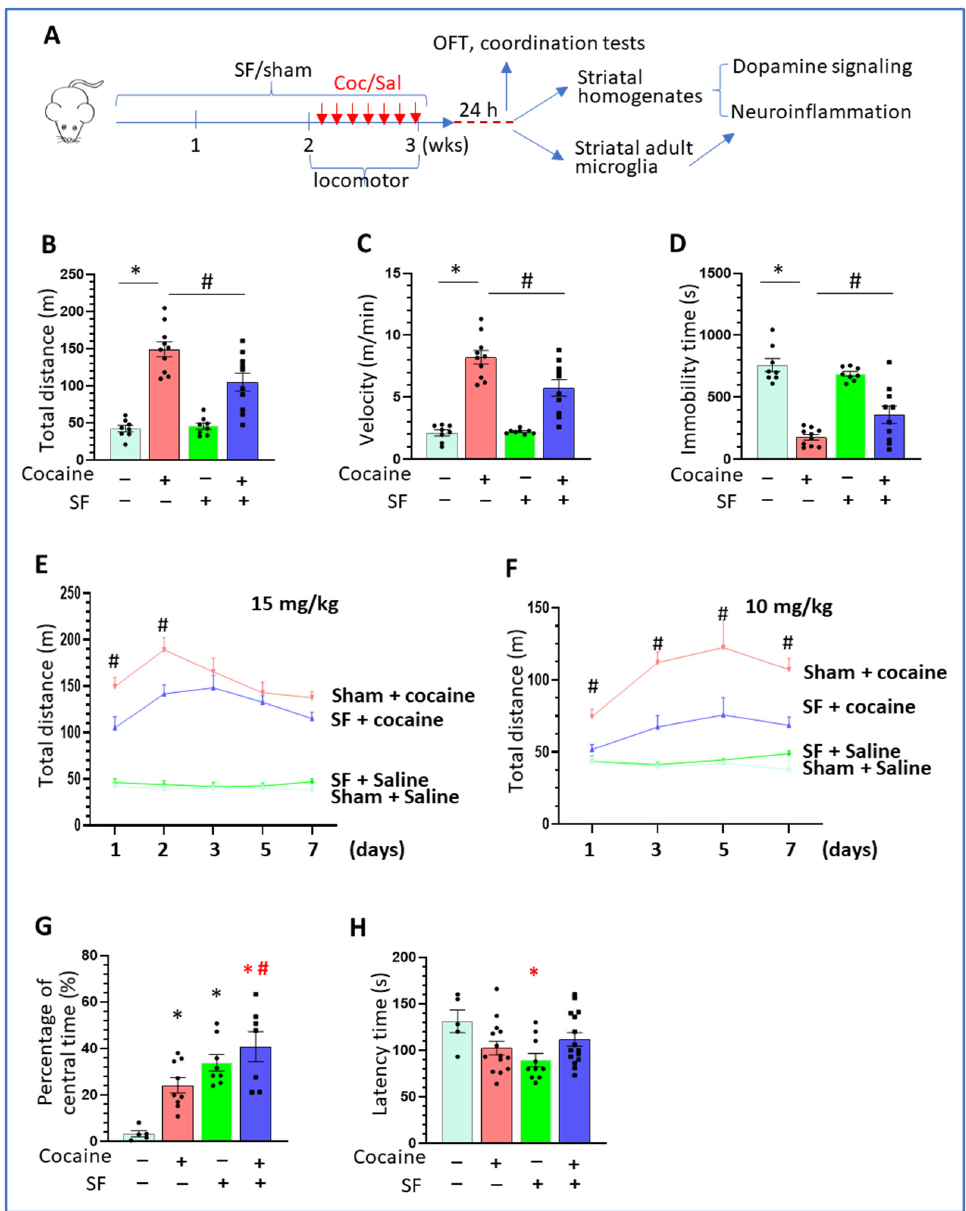
Figure 1. The Effects of SF on cocaine-mediated behavioral changes. ( A ) Schematic for the experimental design. ( B ) Cocaine significantly increased locomotor activity while SF partially blocked this hyperlocomotion (* p < 0.05, vs. sham + saline; # p < 0.05, SF + cocaine vs. sham + cocaine, n = 8–10). ( C ) Cocaine significantly increased the velocity while SF partially blocked this upregulation (* p < 0.05, vs. sham + saline; # p < 0.05, SF + cocaine vs. sham + cocaine, n = 8–10). ( D ) Cocaine significantly decreased the immobility time and SF partially blocked this downregulation (* p < 0.05, vs. sham + saline; # p < 0.05, SF + cocaine vs. sham + cocaine, n = 8–10). ( E ) SF decreased the distance travelled on the first and second day of cociane injection (15 mg/kg) during the 7-day injecition period (# p < 0.05, SF + cocaine vs. sham + cocaine). ( F ) SF decreased the distance travelled throughout the whole 7-day cocaine injection period (10 mg/kg) # p < 0.05, SF + cocaine vs. sham + cocaine). ( G ) Cocaine and SF increased the pecentage time in central area (* p < 0.05, vs. sham + saline; # p < 0.05, SF + cocaine vs. sham + cocaine, n = 8–10). ( H ) SF decreased the latency time of mice in the coordination test (* p < 0.05, vs. sham + saline).